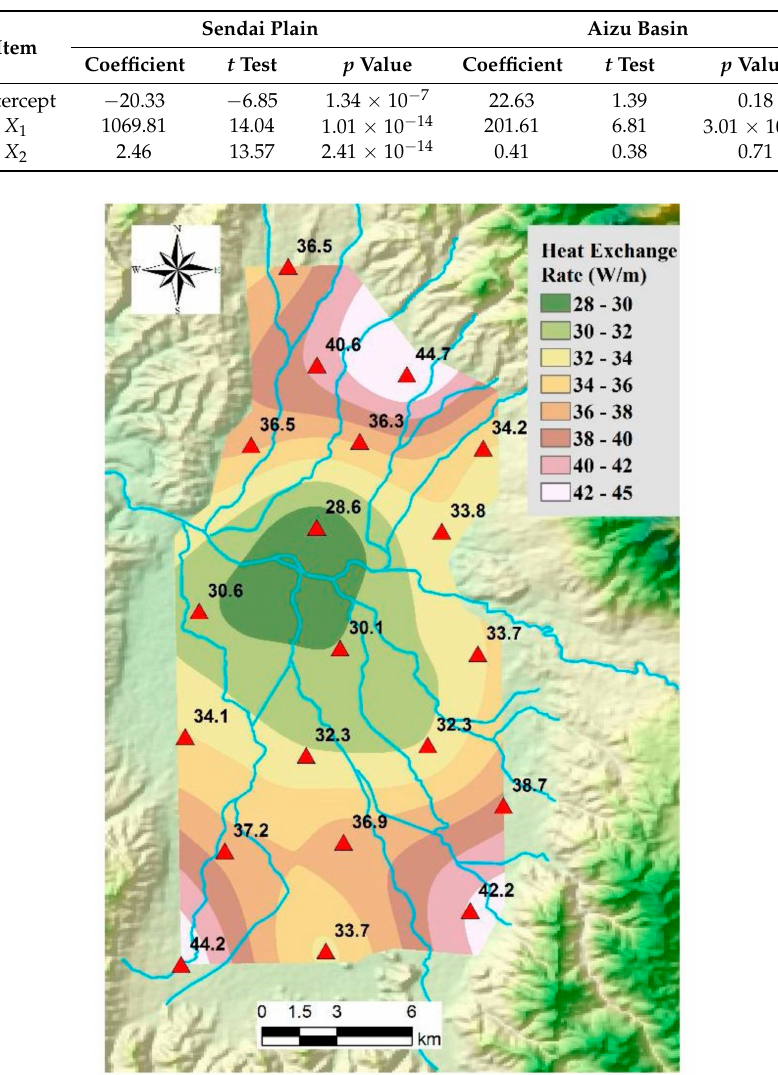
Figure 11. Distribution map of heat exchange rates in the Aizu Basin quoted from Shrestha et al.